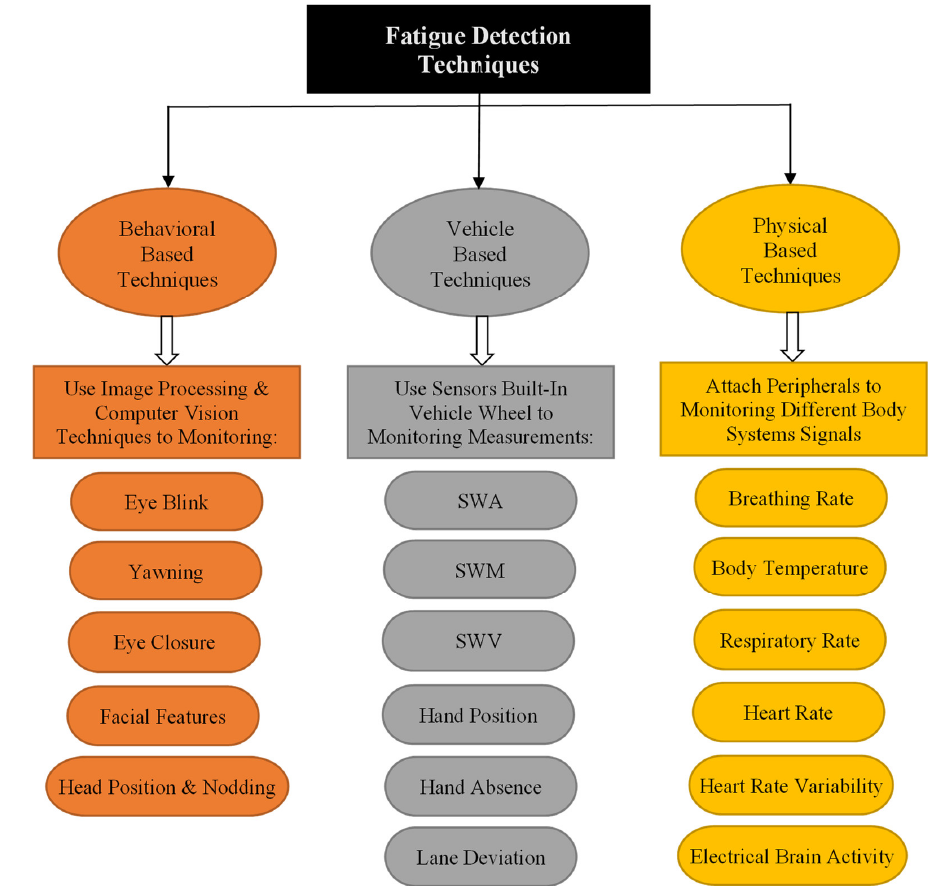
Figure 1. A summary of the major techniques used in fatigue detection